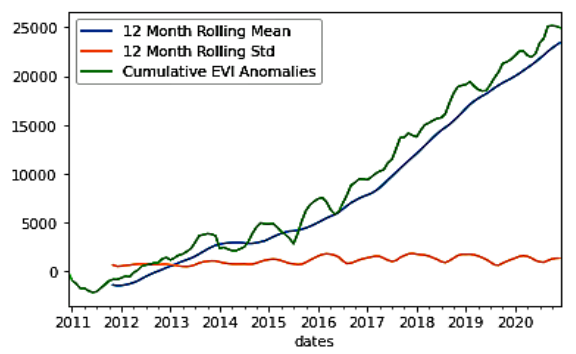
Figure 3. Cumulative EVI anomalies rolling statistics plot.